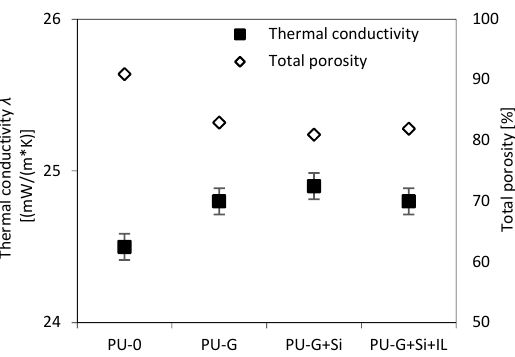
Figure 5. Dependence of the thermal conductivity coefficient at 20 °C on the total porosity of PU foams.